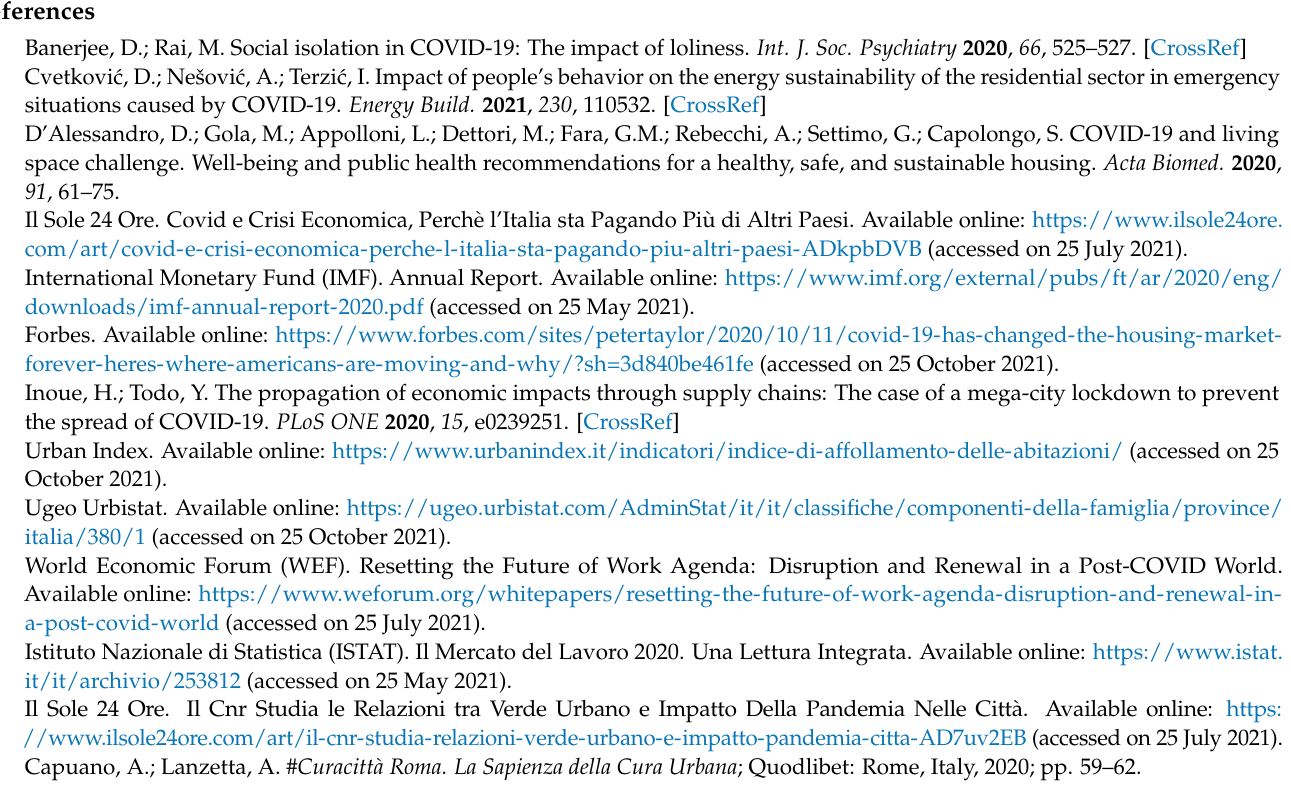
S4. Descriptive statistics of the variables for the city of Rome—Phase I. Table S5. Descriptive statistics of the variables for the city of Naples—Phase I. Table S6. Descriptive statistics of the variables for the city of Catania—Phase I. Table S7. Descriptive statistics of the variables for the city of Turin—Phase II. Table S8. Descriptive statistics of the variables for the city of Milan—Phase II. Table S9. Descriptive statistics of the variables for the city of Florence—Phase II. Table S10. Descriptive statistics of the variables for the city of Rome—Phase II. Table S11. Descriptive statistics of the variables for the city of Naples—Phase II. Table S12. Descriptive statistics of the variables for the city of Catania—Phase II. Table S13. Correlation analysis of the variables for the city of Turin—Phase I. Table S14. Correlation analysis of the variables for the city of Milan—Phase I. Table S15. Correlation analysis of the variables for the city of Florence—Phase I. Table S16. Correlation analysis of the variables for the city of Rome— Phase I. Table S17. Correlation analysis of the variables for the city of Naples—Phase I. Table S18. Correlation analysis of the variables for the city of Catania—Phase I. Table S19. Correlation analysis of the variables for the city of Turin—Phase II. Table S20. Correlation analysis of the variables for the city of Milan—Phase II. Table S21. Correlation analysis of the variables for the city of Florence—Phase II. Table S22. Correlation analysis of the variables for the city of Rome—Phase II. Table S23. Correlation analysis of the variables for the city of Naples—Phase II. Table S24. Correlation analysis of the variables for the city of Catania—Phase